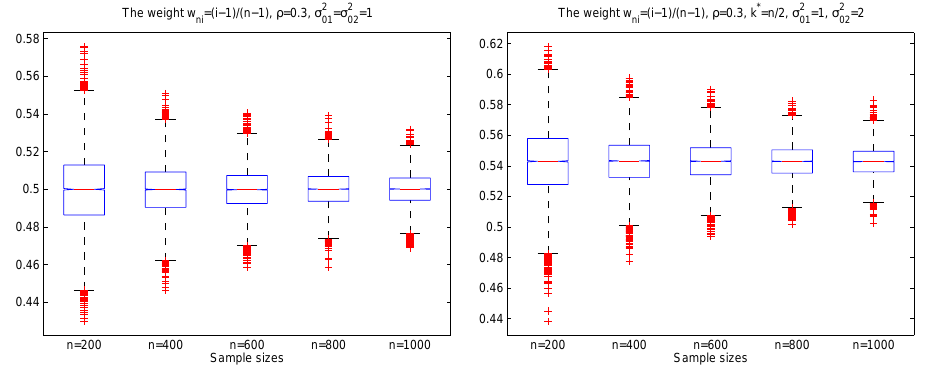
Figure 6. Box plots of X n for the weighted case w ni = i − 1 Y n = 1, σ 2 = and σ 2 02 01